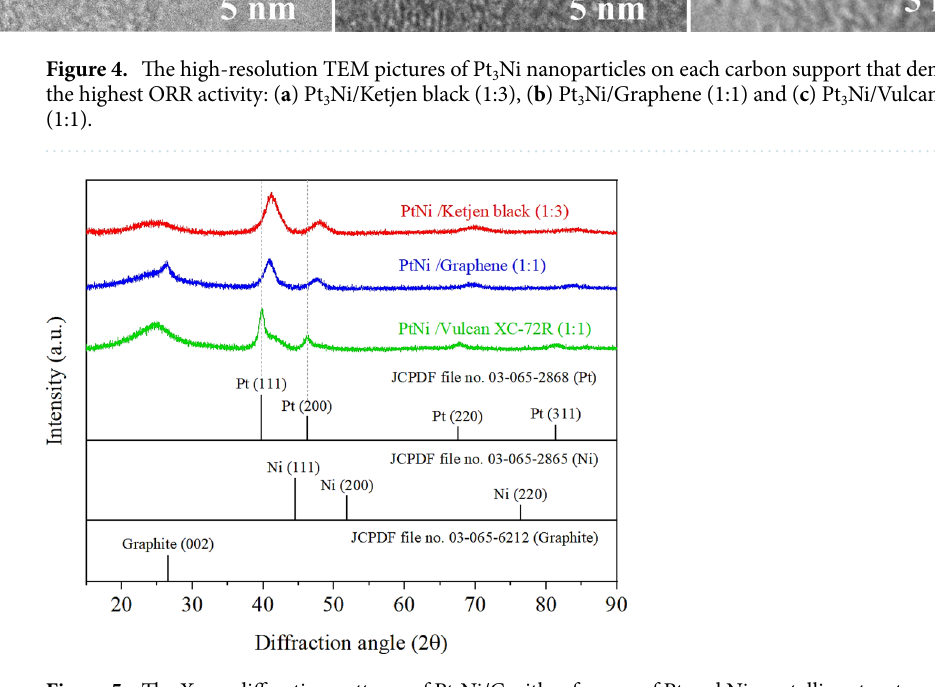
Figure 5. The X-ray diffraction patterns of Pt 3 Ni/C with reference of Pt and Ni crystalline structure from JCPDF: (red line) Pt 3 Ni/Ketjen black (1:3), (blue line) Pt 3 Ni/Graphene (1:1) and (green line) Pt 3 Ni/Vulcan